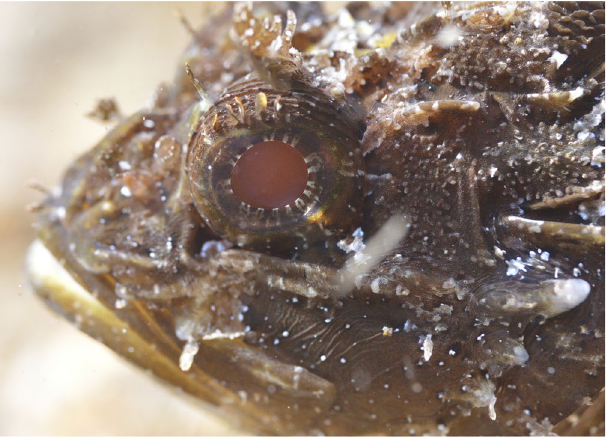
Figure 1. Daytime pupil eyeshine in Scorpaena porcus in the field. Under natural light conditions, the pupil of S. porcus appears lit, unlike most fishes which possess dark pupils. Photo credit: N.K.